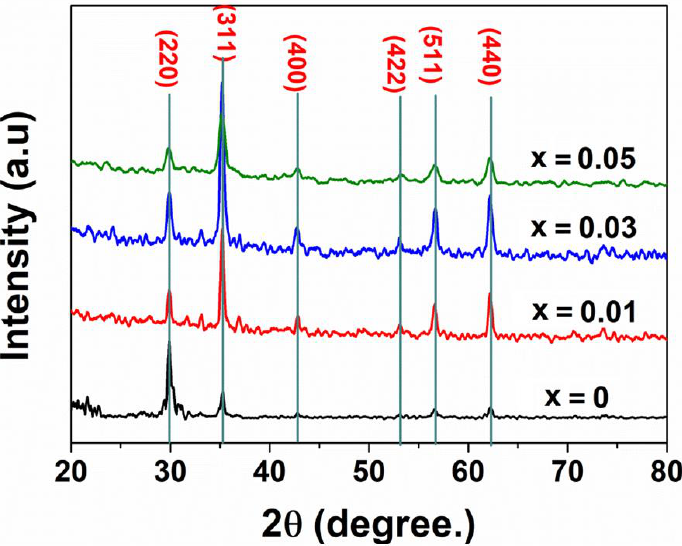
Figure 1. X-ray diffraction patterns of ZnNd x Fe 2 − x O 4 nanoparticles (x = 0.0–0.05) annealed at 500 ◦ Figure 1. X−Ray diffraction patterns of ZnNd x Fe 2−x O 4 nanoparticles (x = 0.0–0.05) annealed at 500 °C.